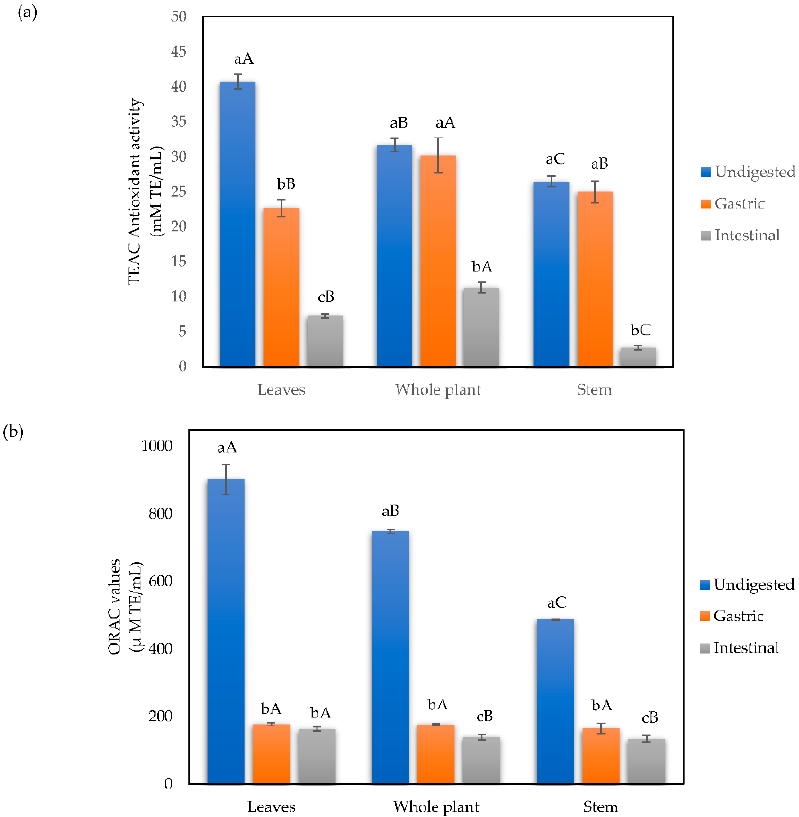
Figure 4. Antioxidant capacity by the ( a ) TEAC and ( b ) ORAC methods of leaves, whole plant, and stem mistletoe infusions subjected to simulated in vitro gastrointestinal digestion. Different letters indicate statistical significance ( p < 0.01) by Tukey’s test. Data shown as means ± SD of three replicates (n = 3). Means that do not share capital letters show statistical differences between values per plant part in each digestive phase by the Tukey test ( p <